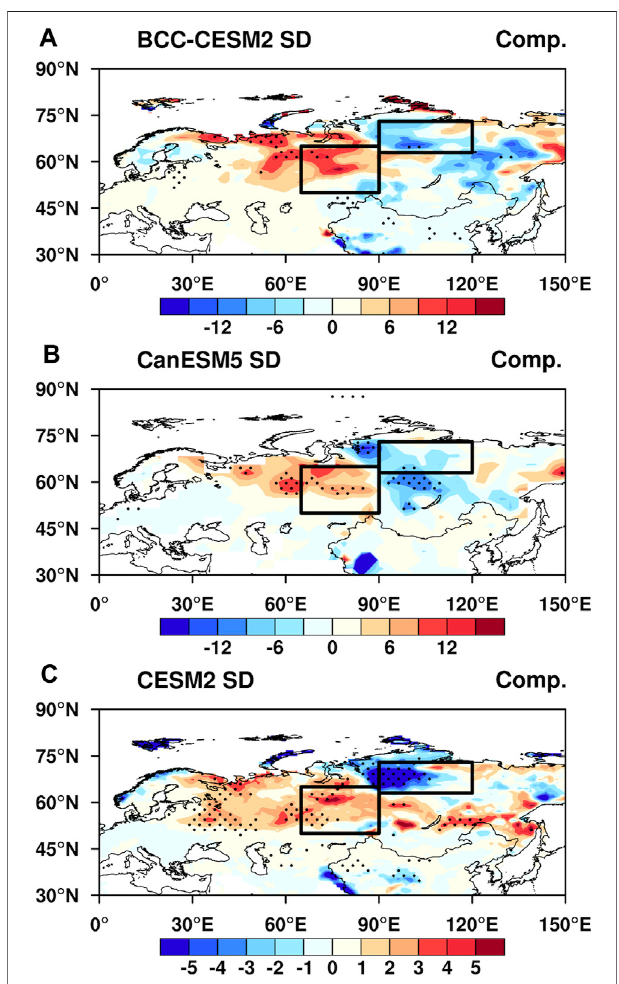
FIGURE 8 | Composite spatial patterns of SD (units: mm) in November between SH + − and SH − + in each model during 2000 – 2018: (A) fi rst group of BCC-CSM2; (B) thirteenthgroupofCanESM5; (C) ensemble(seventhtoninth group) of CESM2. Dotted regions are statistically signi fi cant at the 90% con fi dence level, based on the t -test. The black rectangle represents the key area of SSD [(50 ° – 65 ° N, 65 ° – 90 ° E), (63 ° – 73 ° N, 90 ° – 120 ° E)].